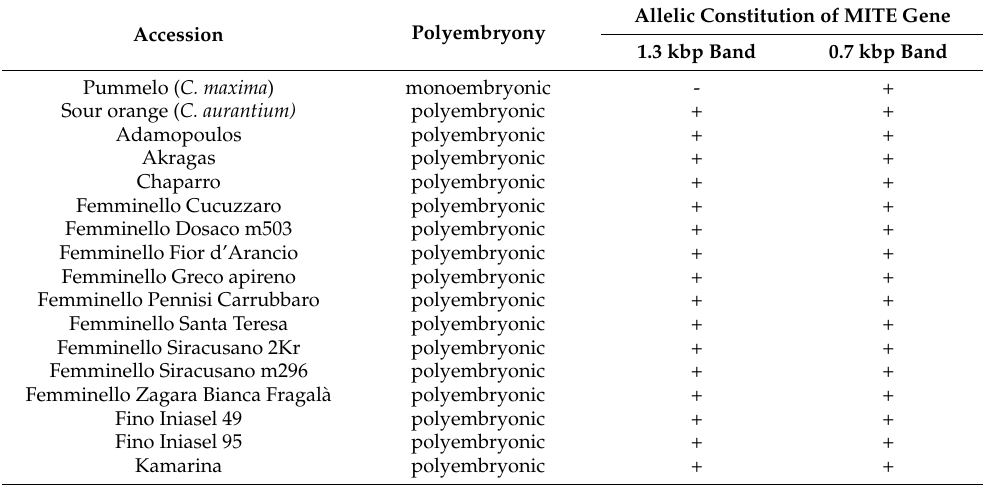
Table 5. Results of the allelic genotyping PCR for the MITE insertion in the CitRKD1 gene on a subset of citrus accessions included in the present